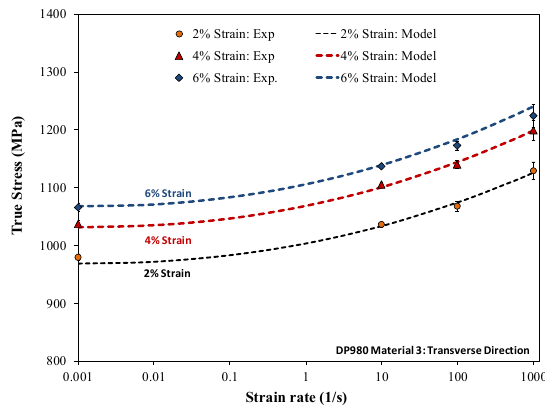
Fig. 17. Comparison of experimental and CS predicted equivalent stress and equivalent plastic strain for Material 2.